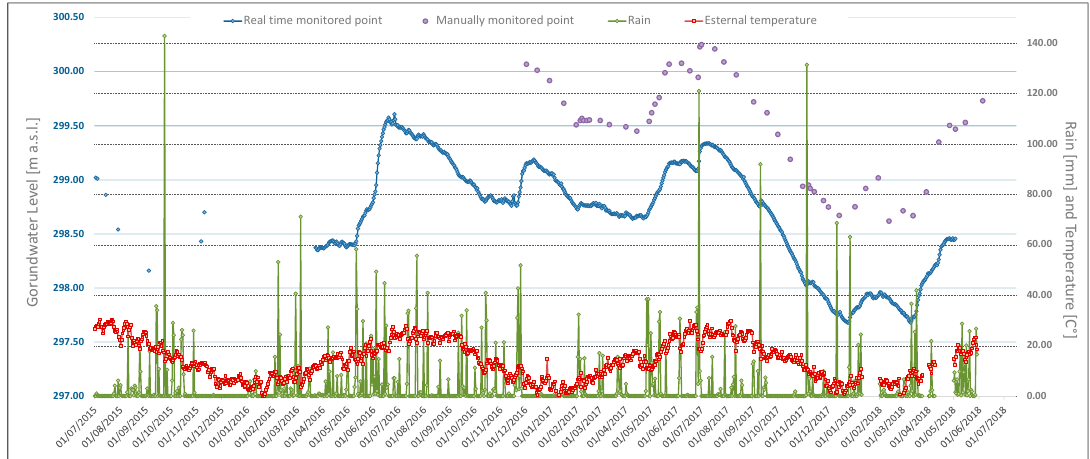
Figure 5. Monitoring data for the two points located in the flooded zone.